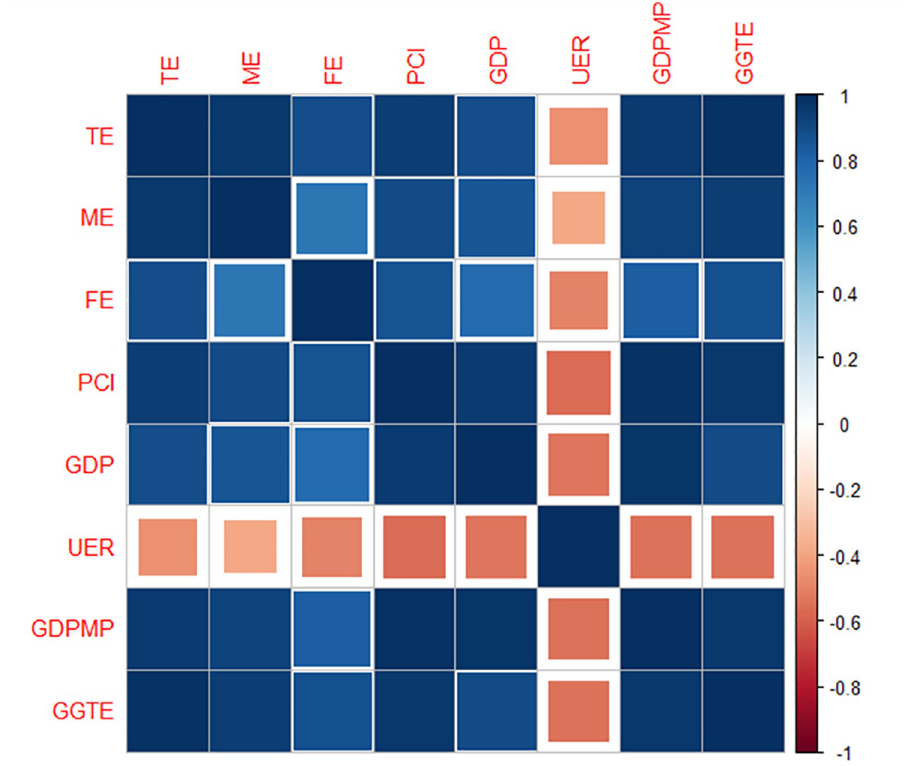
Fig 2. Correlation between student’s enrollment in higher education institutions of Pakistan and different socio- economic indicators using data acquired from 2001–02 to 2015–16 fiscal year. TE: Total enrollment; ME: Male enrollment; FE: Female enrollment; PCI: Parental income; GDP: Gross domestic Production; UER: Unemployment rate; GDPMP: Gross domestic production market price; and GGTE: General government expenditure.